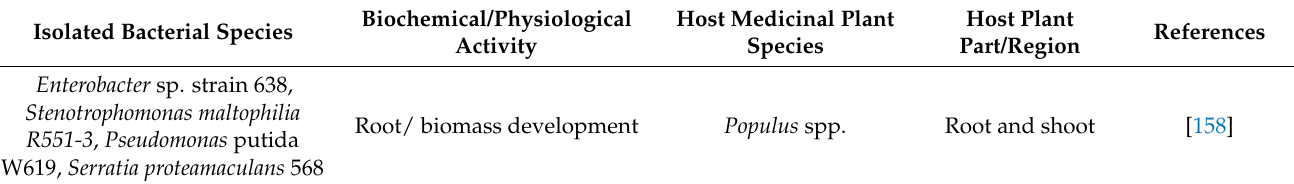
Table 2. Growth-promoting bacteria and associated secondary metabolites from medicinal and herbal plant